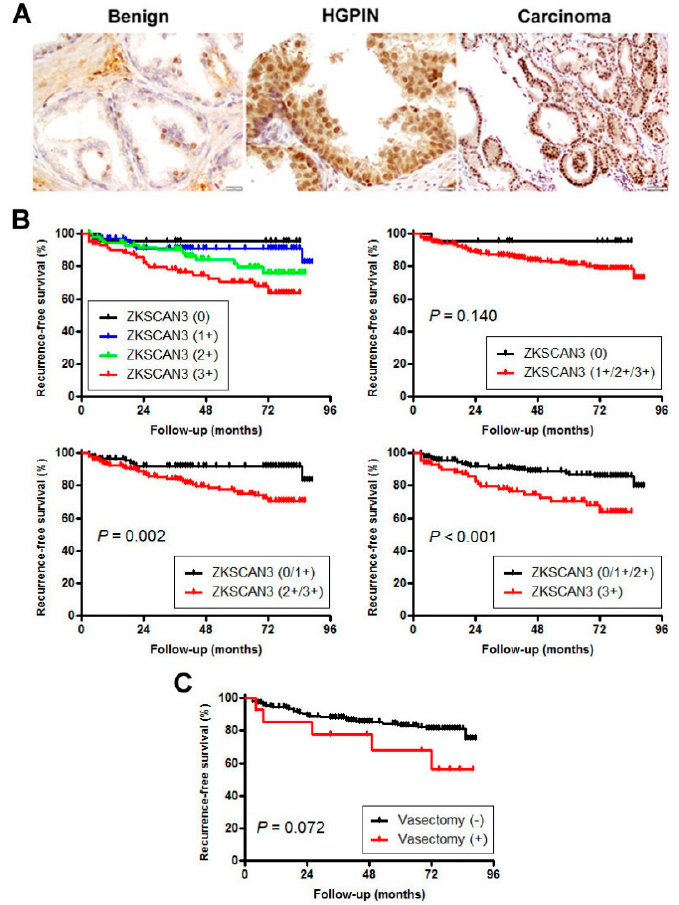
Figure 3. Expression of ZKSCAN3 in radical prostatectomy specimens. ( A ) Representative images